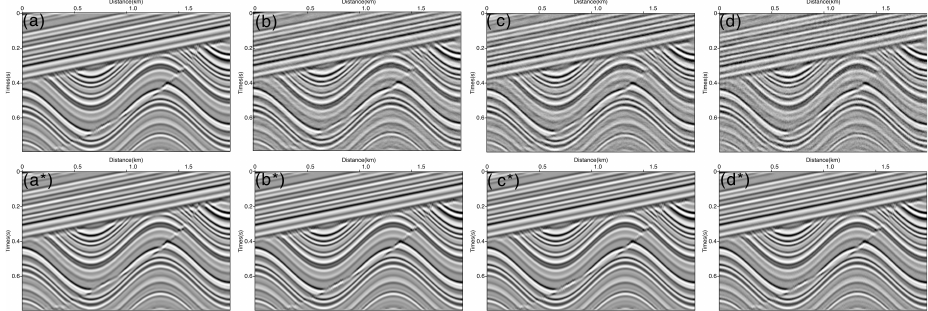
Figure 6. The comparison of DnCNN and FACNN with respect to the different noise levels. ( a – d ) are the DnCNN denoised results. ( a* – d* ) are the corresponding FACNN denoised.